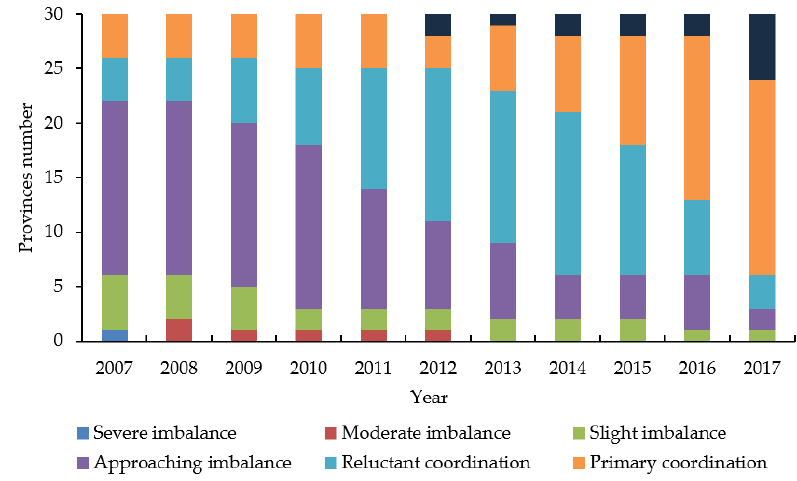
Figure 3. Changes of the coupling coordination rank.